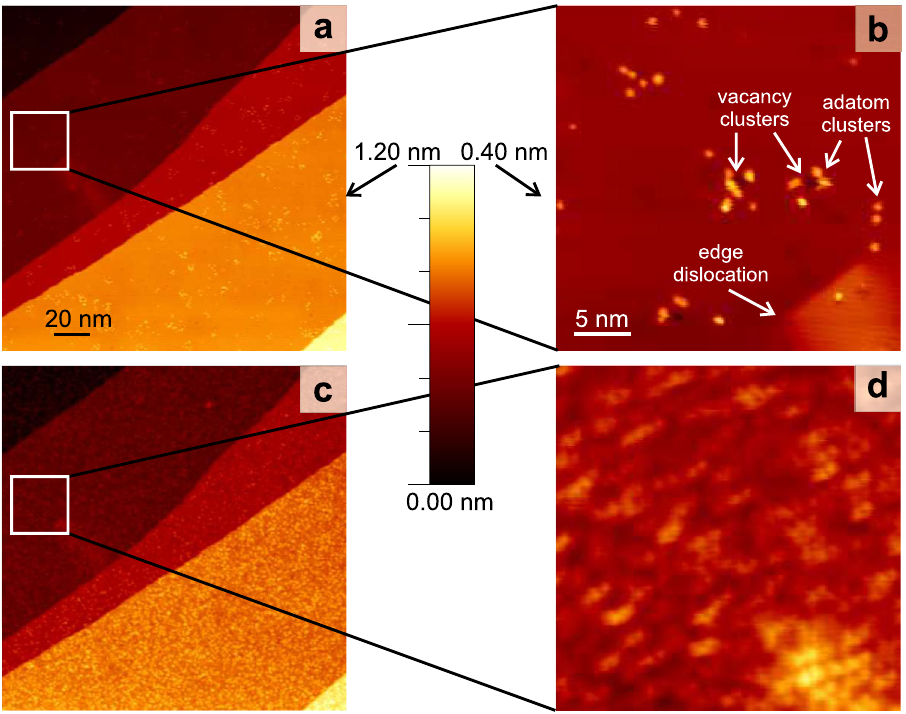
Figure 3. Laser-induced changes: surface before ( a , b ) and after ( c , d ) illumination with 290 µ J/cm 2 absorbed SPP fluence, 10 7 pulses; ( a , c ) overview images ( b , d ) zoom into squares marked in (a,c); V t = 113 mV , I t = 55 pA , on false-color scale as